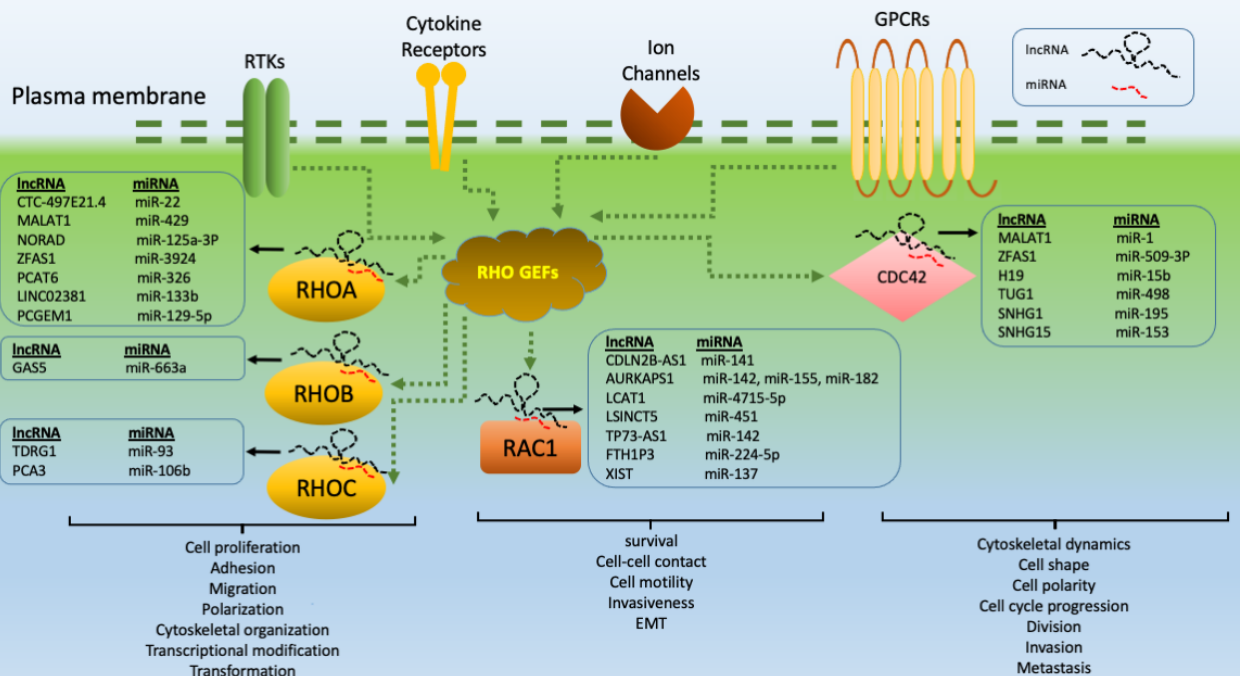
Figure 2. RHO GTPase-related lncRNAs. RHO GTPases are activated by RHO GEFs via different receptors, including GPCRs (G-protein coupled receptors with various ligands, such as Angiotensin II, Endothelin, LPA, S1P1, Thrombin, and Thromboxane A2), RTKs (receptor tyrosine kinases with ligands, such as EGF, Ephrins, NGF, PDGF, and VEGF), ion channels (with ligands, including nicotinic acetylcholine or glutamate), and cytokine receptors (with ligands, including Interferons, Interleukins, and Tumor necrosis factors). Members of the RHO GTPase family, such as RHOA, RHOB, RHOC, RAC1, and CDC42, are modulated by lncRNAs, which are the key regulators of gene expression. They play essential roles in a wide variety of signaling pathways, and thus processes involved in tumor progression. lncRNAs act as ceRNAs by sponging tumor suppressor miRNAs, thereby indirectly regulating the expression of genes related to RHO GTPases.